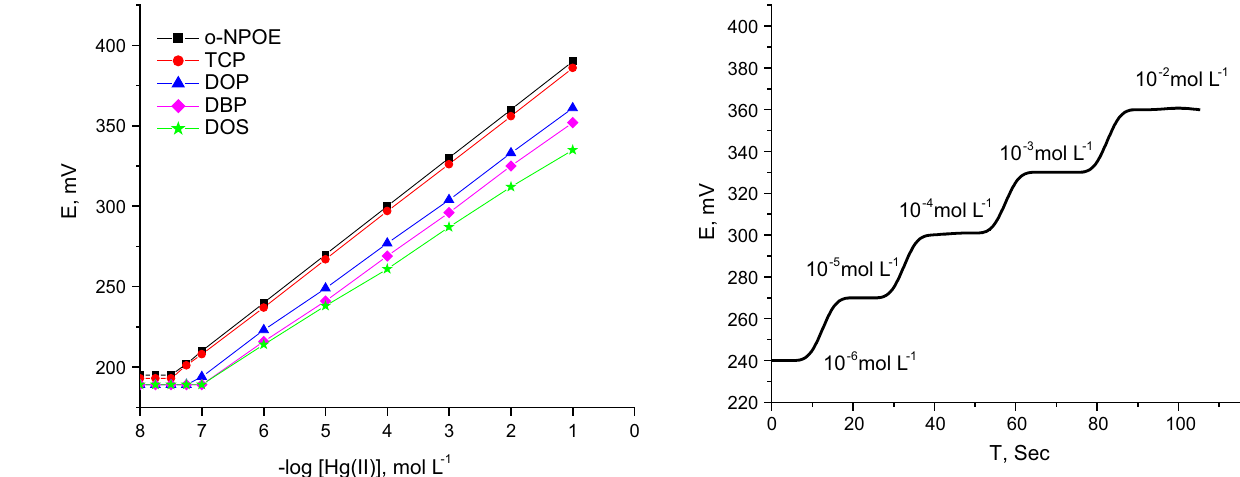
Fig. 3 Effect of plasticizer type on calibration of the modified SPE sensor